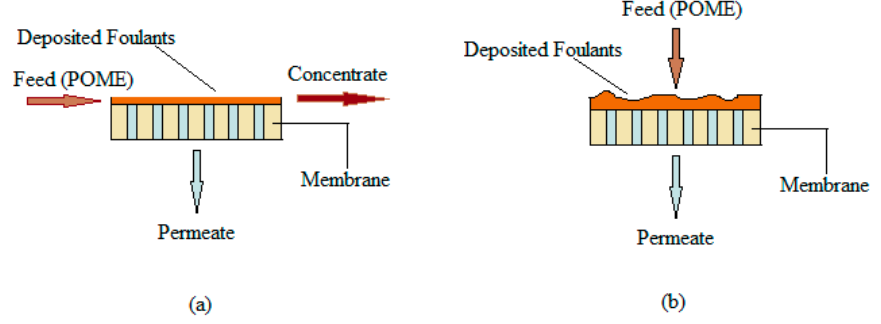
Figure 2. Schematic of membrane operation ( a ) cross-flow and ( b ) dead-end filtration.